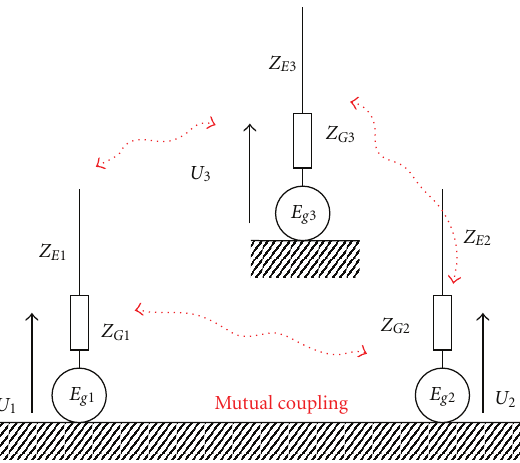
Figure 1: Illustration of couplings between antennas.